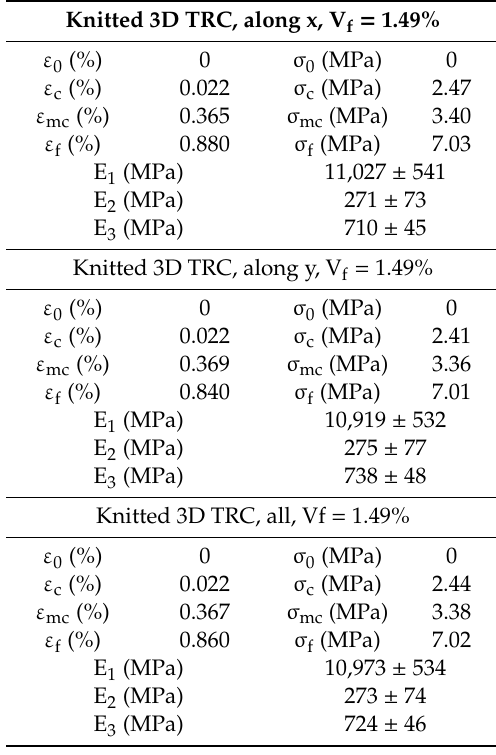
Table 3. Averaged tensile experimental parameters for the knitted 3D TRC layup, as well as model